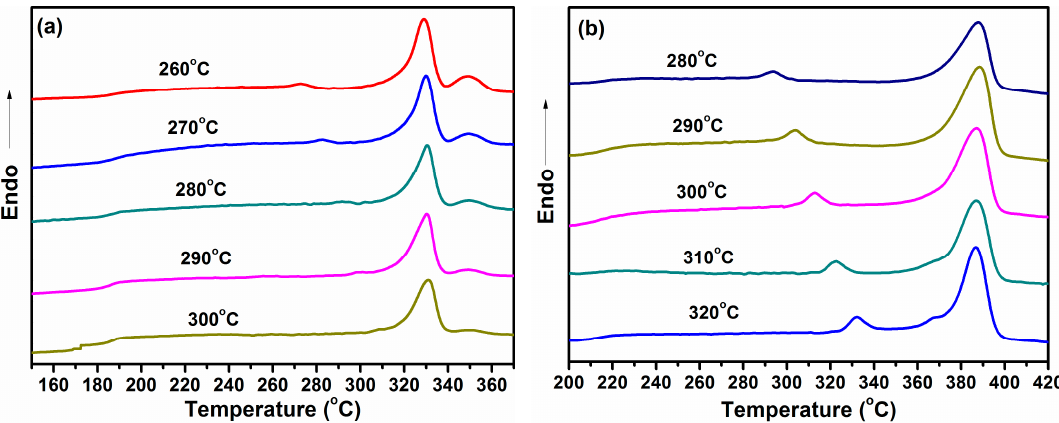
Figure 6. DSC scans for samples isothermally crystallized at various temperatures: ( a ) PI-1; ( b )